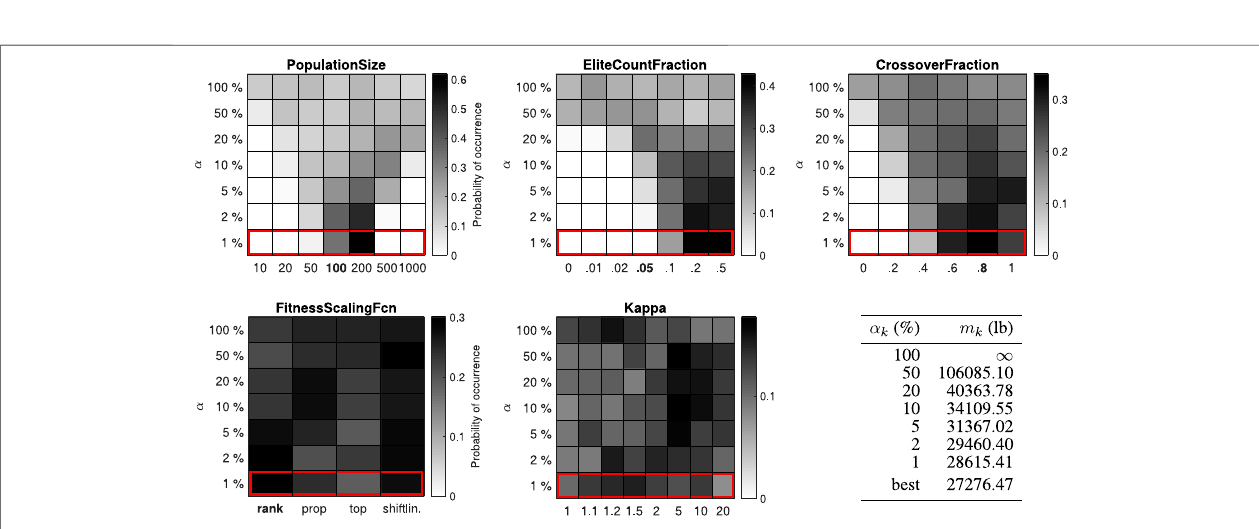
FIGURE 7 | Distribution of control parameter values for the 200-bar truss test problem (29 design variables).